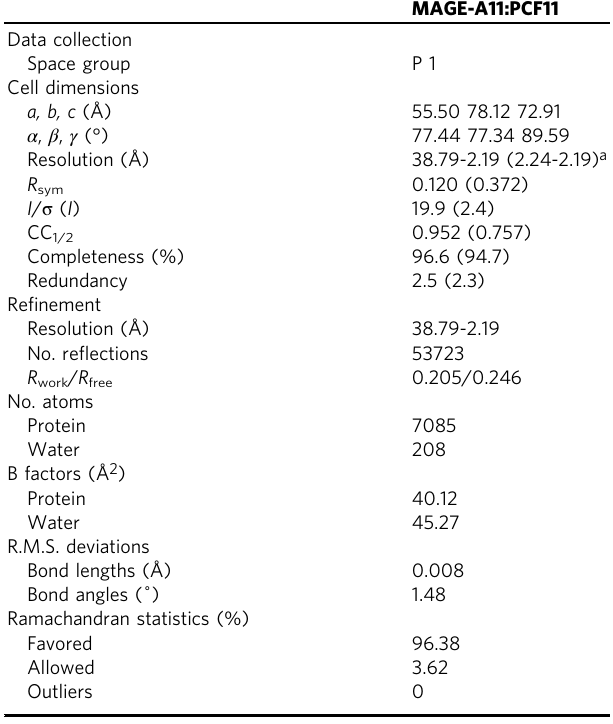
Table 1 Data collection and re fi nement